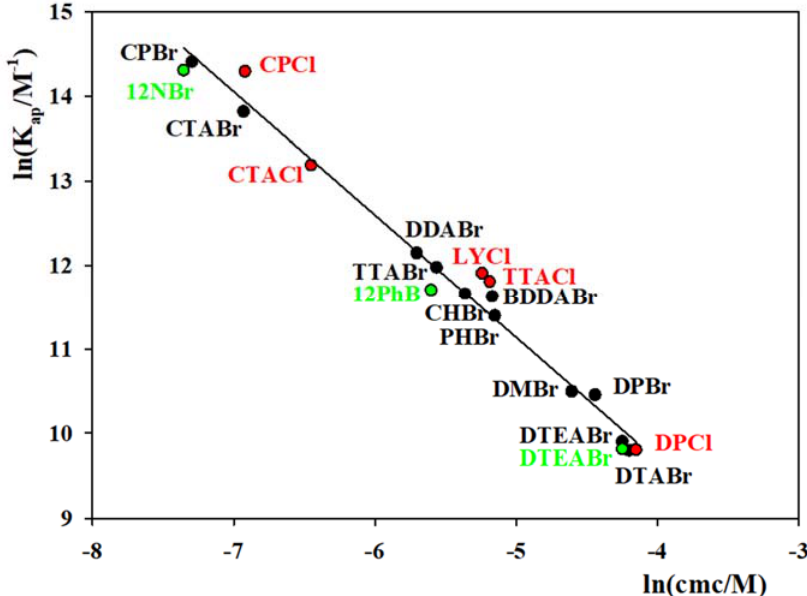
Figure 4. Plot of ln(Kapp) vs. ln(cmc) for the different surfactants investigated. Black circles: bromide surfactants; red circles: chloride surfactants; green circles: bromide surfactants investigated in this work. T = 303 K. CTABr: Hexadecyltrimethylammonium bromide;